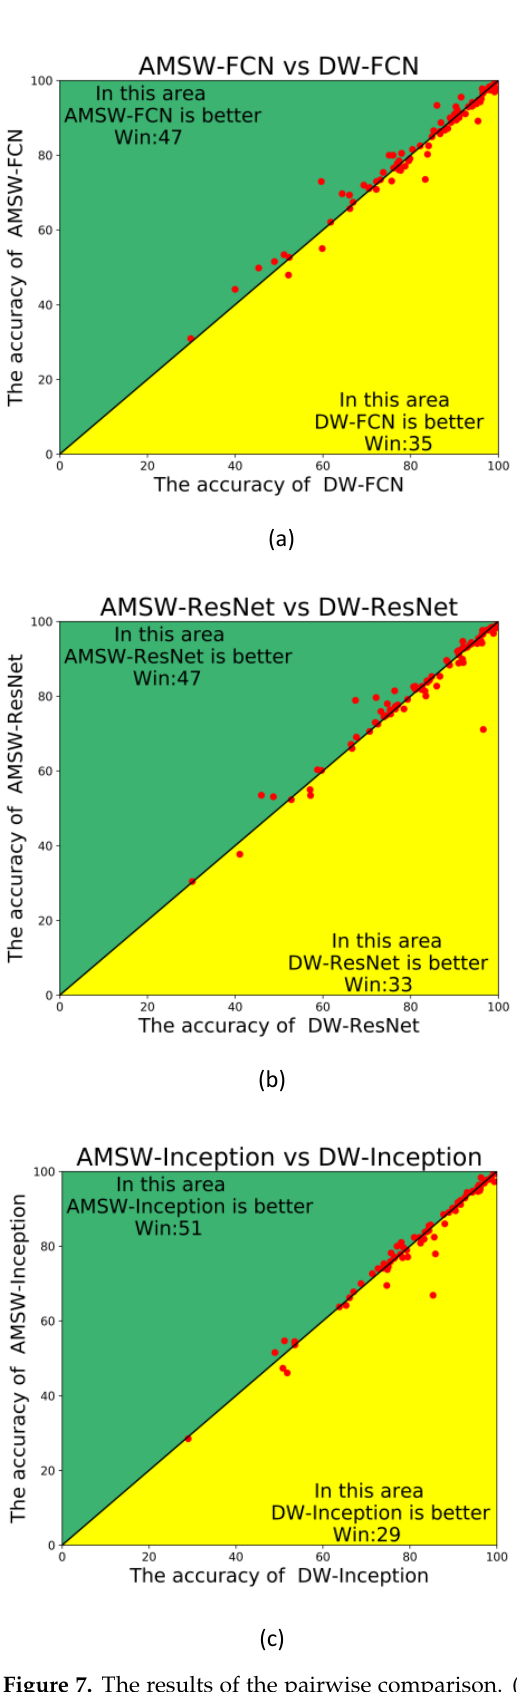
Figure 7. The results of the pairwise comparison. ( a ) shows the accuracy of AMSW-FCN against DW-FCN, ( b ) shows the accuracy of AMSW-ResNet against DW-ResNet, ( c ) shows the accuracy of AMSW-Inception against